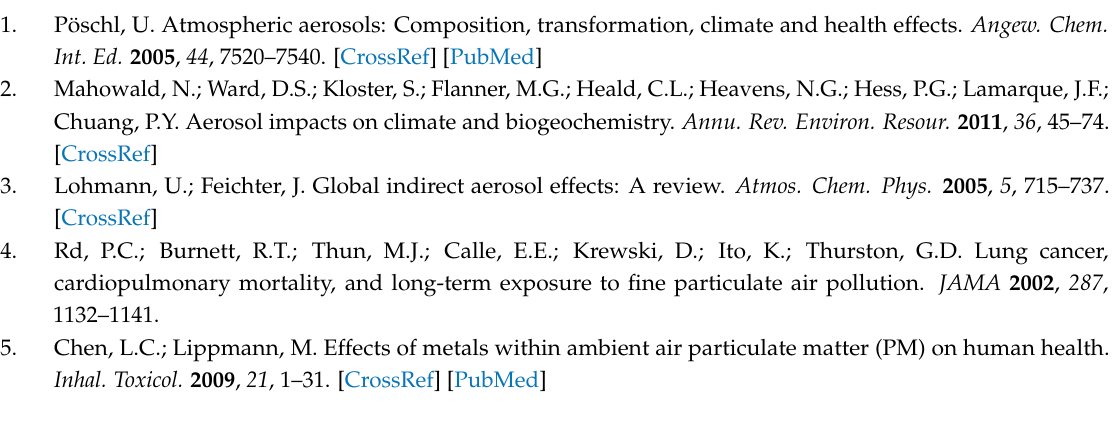
Figure S1: A comparison between two days (26 July 2014 and 29 July 2014) with similar surface reflectance (around 0.4), but with different MODIS retrieved AODs. The open-source codes for the retrieval algorithm can be accessed in the supplementary